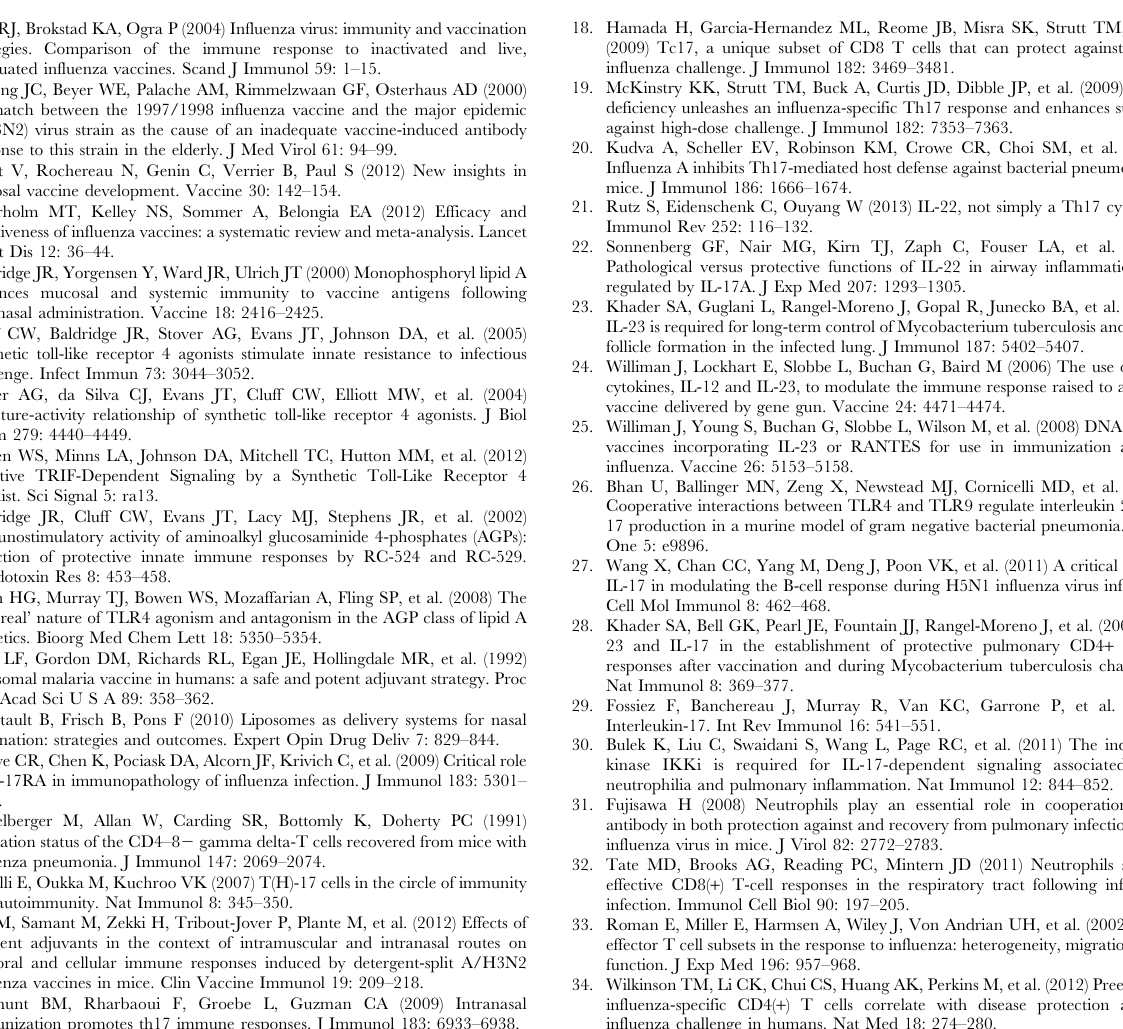
Figure S3 Induction of Th17 cells following strict